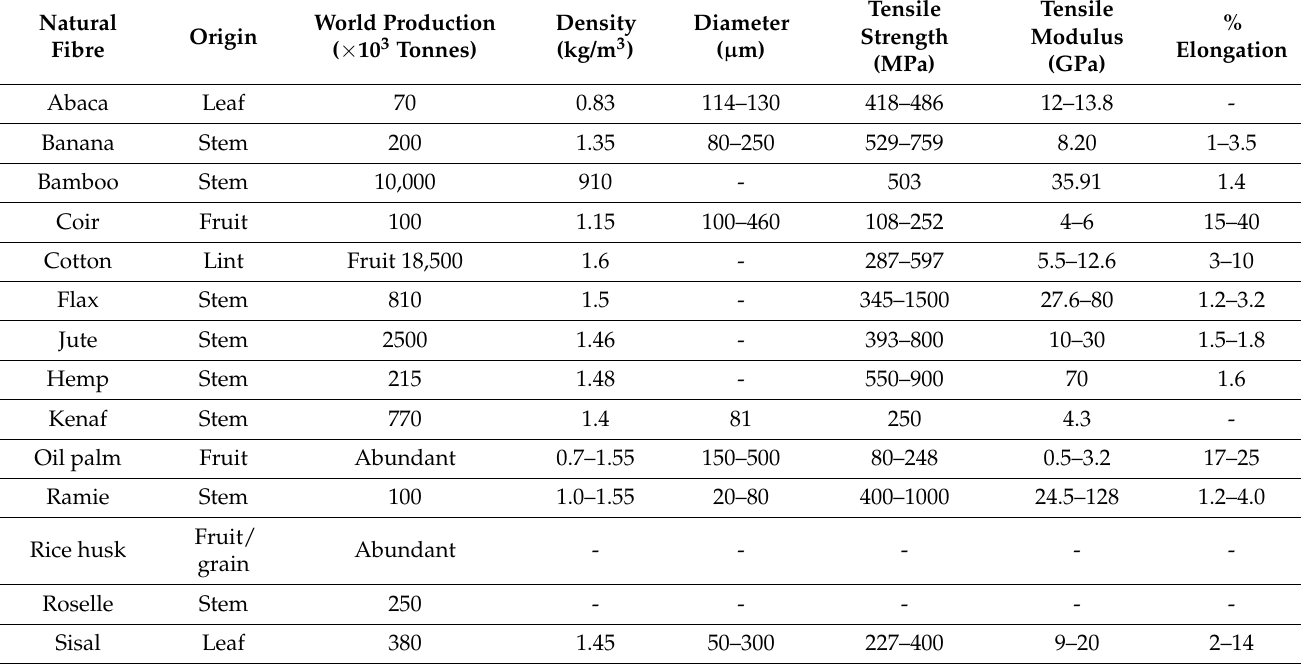
Table 1. Origin and properties of natural fibres. Reprinted with permission from Ref. [79]. Copyright 2021 Wiley